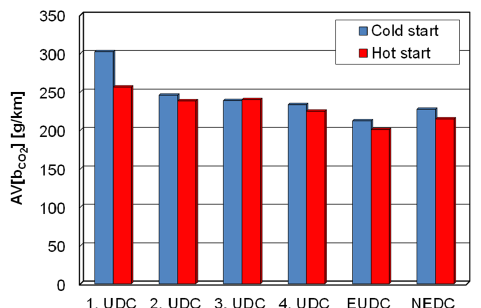
Figure 14. Average carbon dioxide emissions (AV[b CO2 ]) in four parts as well as in the NEDC test for cold and hot starts.